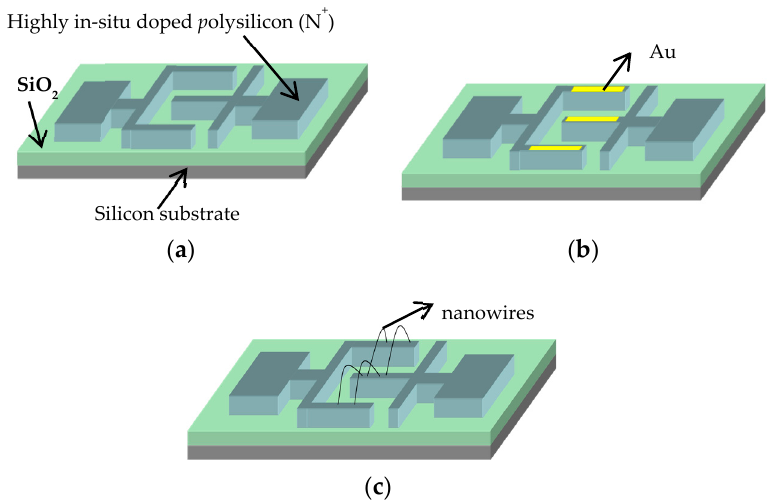
Figure 1. Key device fabrication steps of the inter-digitated comb-shaped SiNWs based resistors. ( a ) Definition of the comb shape heavily in-situ doped polysilicon electrodes geometry on a SiO 2 capped substrate; ( b ) Thin film Au local deposition after lift-off technique; ( c ) Growth of Au-catalyst VLS SiNWs by